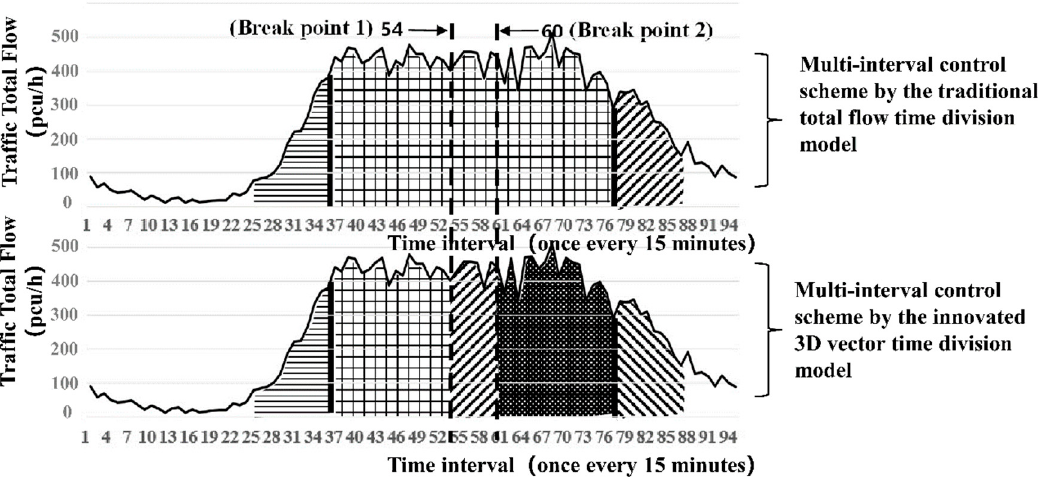
Figure 10. Scheme comparison diagram of the 3D vector time period division with the traditional total flow division (constant-peak-type representative: No. 79 intersection at Pingjiang Road and Renmin East Road).